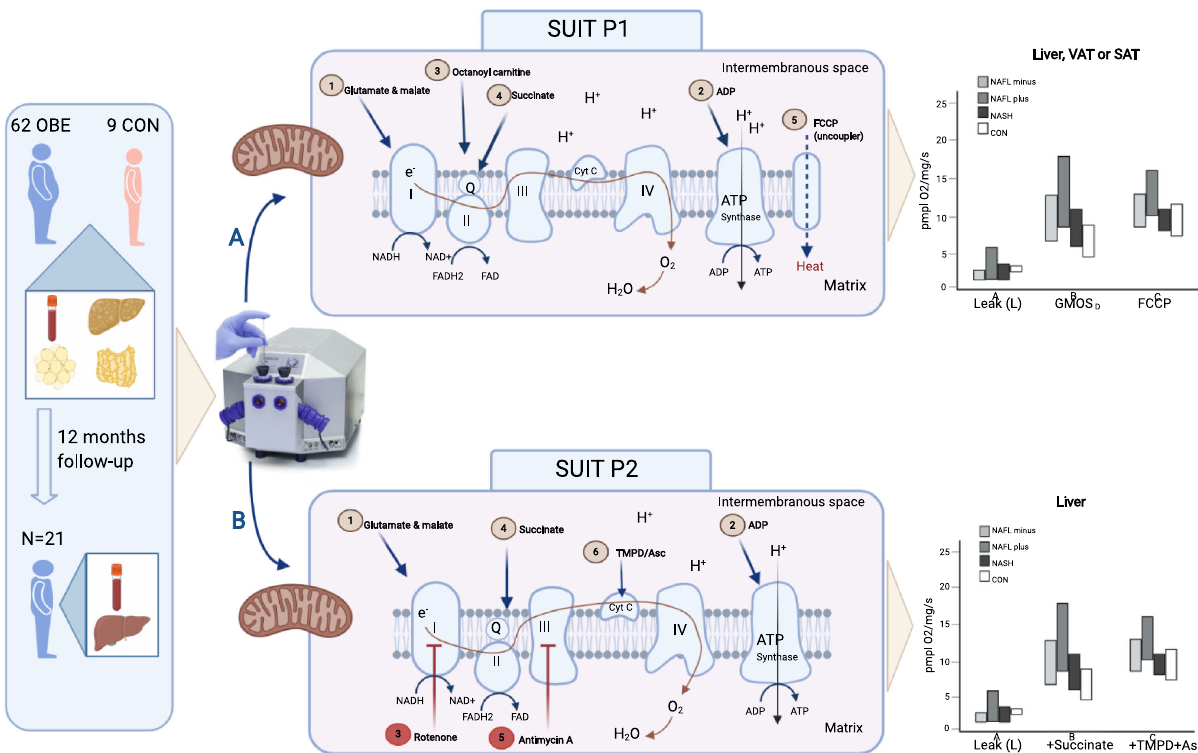
Fig. 1 Depiction of the experimental study set-up. Liver tissue, visceral adipose tissue (VAT) and subcutaneous adipose tissue (SAT) were sampled from 62 patients undergoing surgery — Roux-en-Y gastric bypass ( n = 29) or sleeve gastrectomy ( n = 33) — and strati fi ed into three groups: 31 patients without liver steatosis (NAFL − ); 16 patients with liver steatosis (NAFL + ); and 15 patients with NASH (NASH). Nine normal weight control subjects without